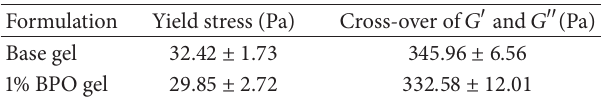
Table 2: Yield stress and cross-over of 𝐺 󸀠 and 𝐺 󸀠󸀠 of tested formulations a